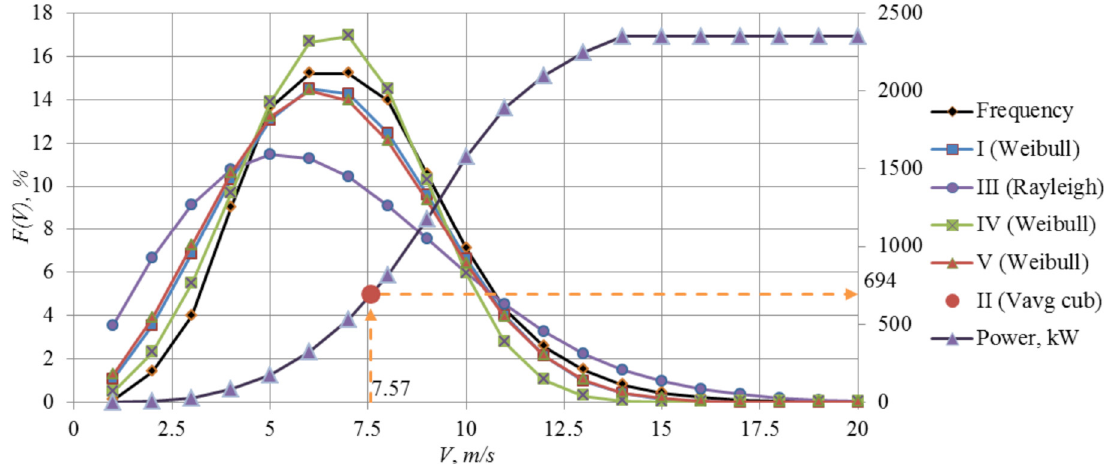
Fig. 4. Curves of wind speed frequency distributions F ( V ) (%), by Weibull and Rayleigh, the power curve P ( V ) (kW) of WT type E82 for the height of 100 (m) and the corresponding value of average cubic wind speed V avg cub